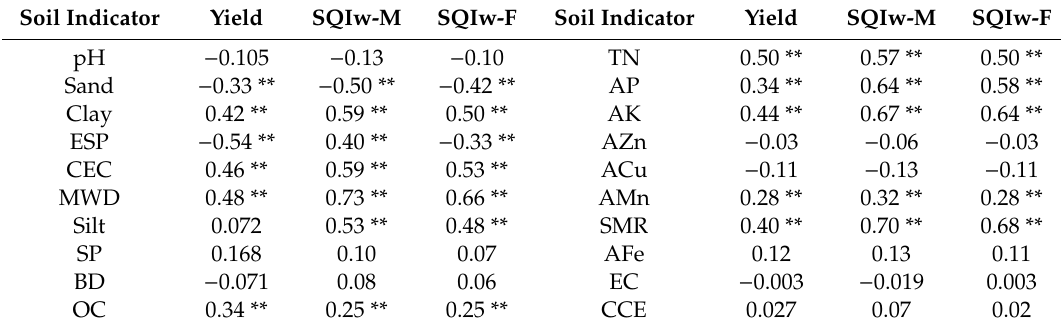
Table 3. Pearson’s correlation coe ffi cients for soil properties between soil quality indicators (SQIs), and